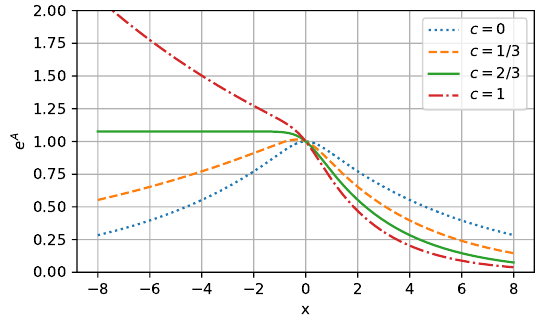
Figure 2 . Plots of warp factor e A ( x ) of the polynomial model with κ = 1